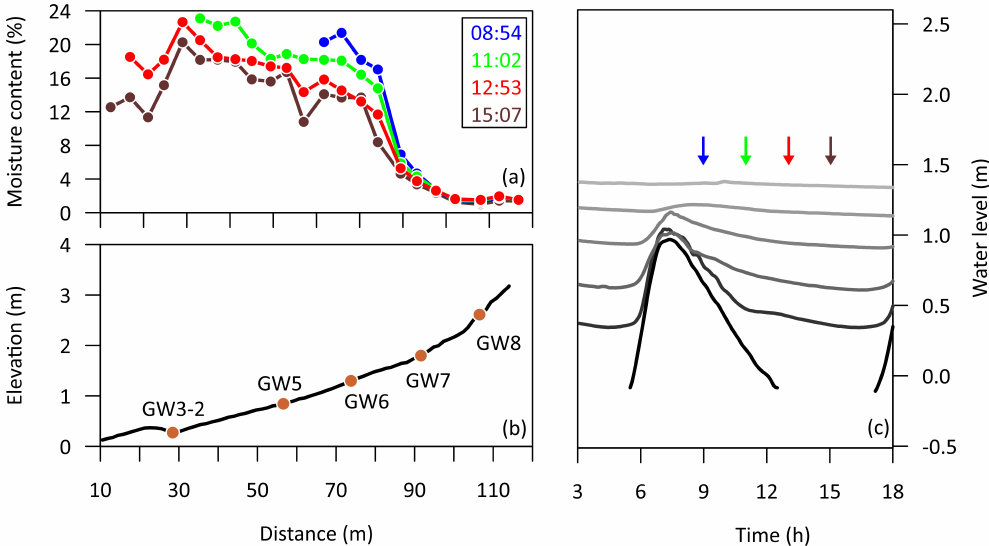
Figure 8. ( a ) Surface moisture content w s at four time intervals during falling tide and ( b ) bed elevation z versus cross-shore distance x on 26 October, a day without a surge. ( c ) shows time series of water level at five groundwater wells, from light to dark gray in seaward direction: GW8, GW7, GW6, GW5 and GW3-2; for their precise location, see ( b ). The black line in ( c ) is the water level at the PT; no data are available at low tide because the PT was not submerged. The four vertical arrows mark the moment of moisture sampling, with the same color coding as in ( a